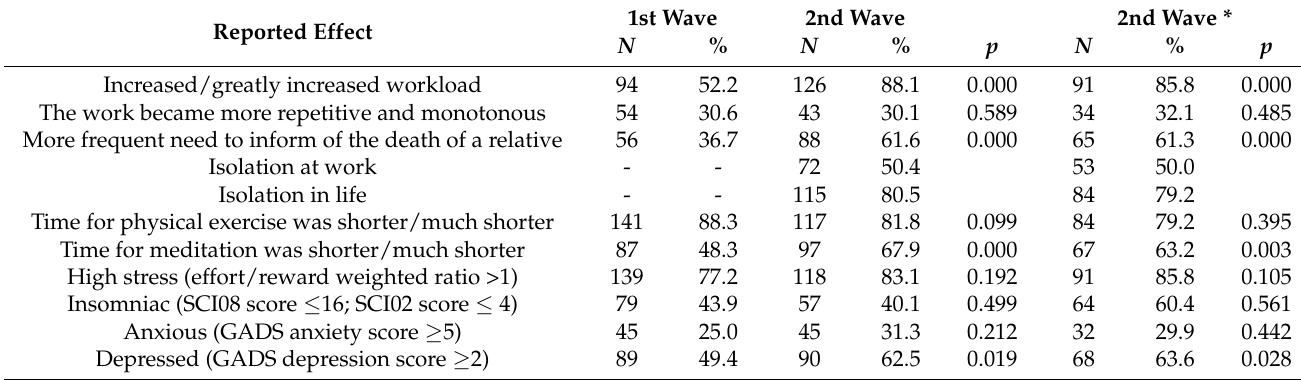
Table 2. Changes reported during the COVID-19 outbreak and prevalence of high stress, insomnia, anxiety, and depression during the 1st and 2nd waves.